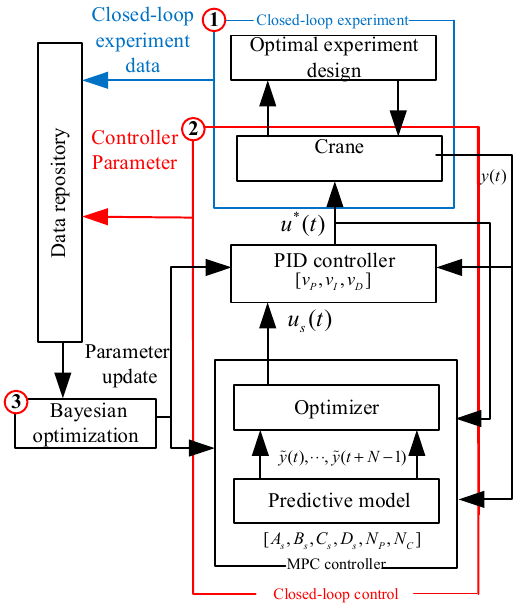
Figure 1. Performance-driven MPC algorithm